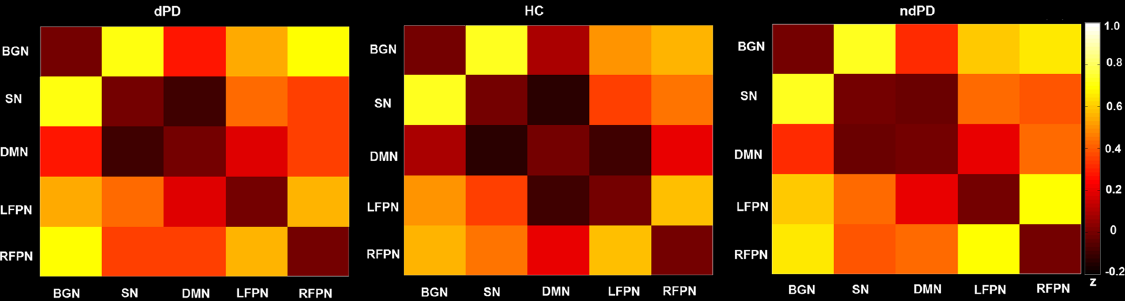
Figure 3. Internetwork connectivity matrix for dPD, HC and ndPD. Pairwise Pearson’s correlations between time courses of selected ICNs (BGN, DMN, LFPN, RFPN, and SN) were Fisher-z-transformed, averaged across subjects for each group, and presented in a correlation matrix. Colors represent intensity of averaged z-scores.